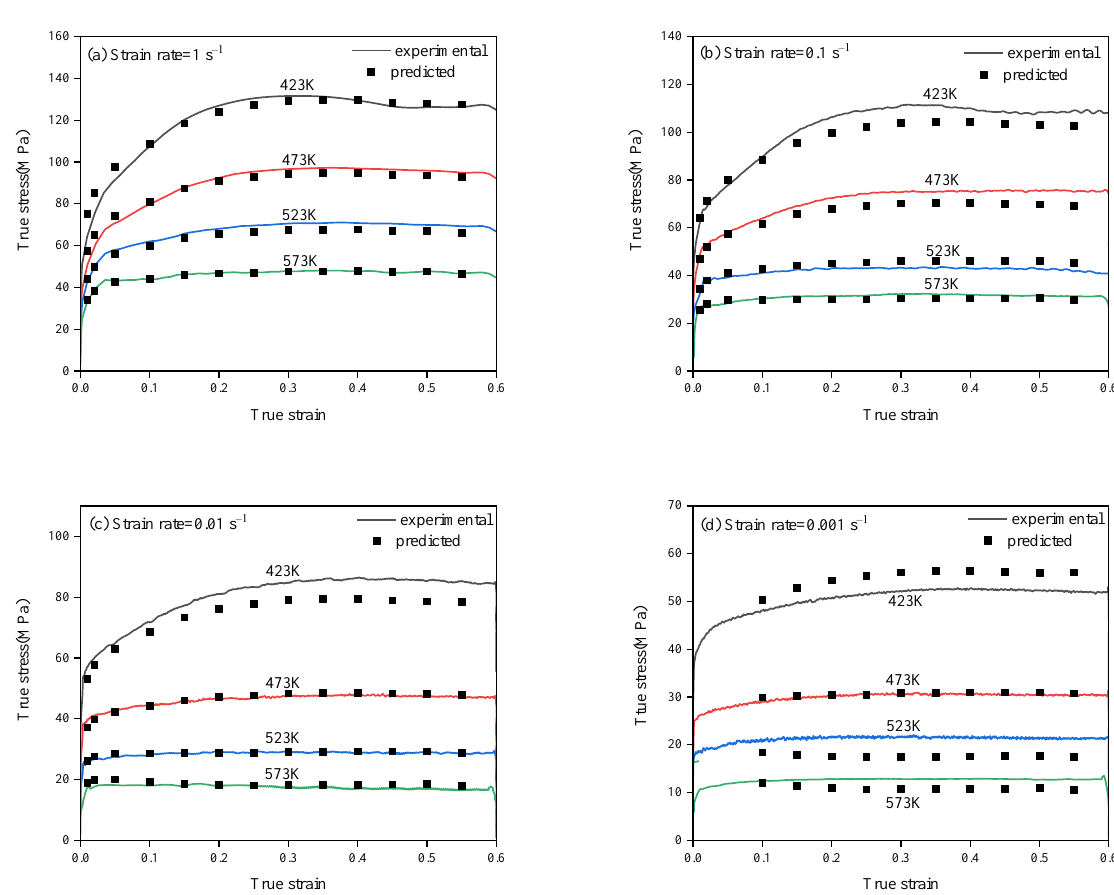
Figure 8. Comparison of predicted values and experimental values at different deformation conditions.